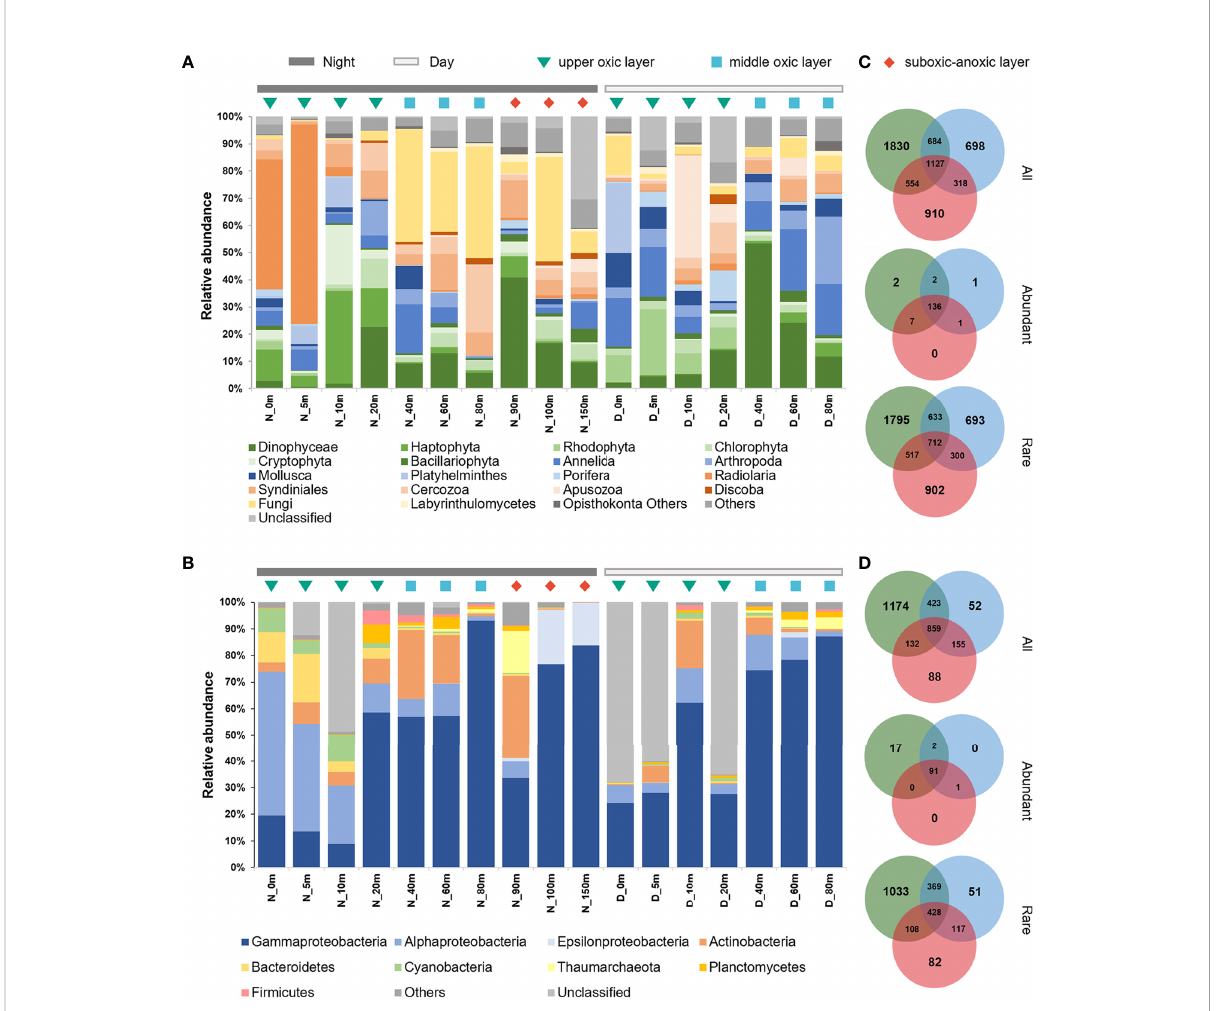
FIGURE 2 Community composition of plankton microbiome in the SYBH. The relative abundances of microeukaryotic (A) and prokaryotic (B) plankton community across depths and time of the day. D, Day; N, Night. Venn diagrams showing the numbers of unique and shared OTUs of microeukaryotes (C) and prokaryotes (D) among three layers. All, whole community; Abundant, abundant plankton subcommunities; Rare, rare plankton